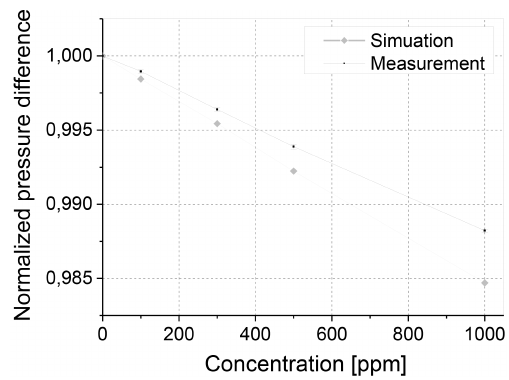
Figure 8. Comparison of measurement and simulation results for our PAS